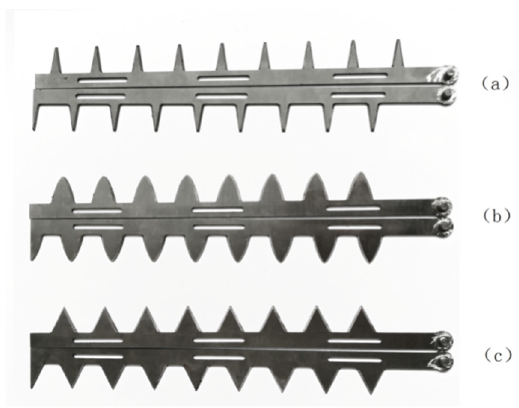
Figure 8. Three reciprocating cutters: ( a ) ordinary cutter; ( b ) bionic cutter e: ( c ) bionic cutter f .